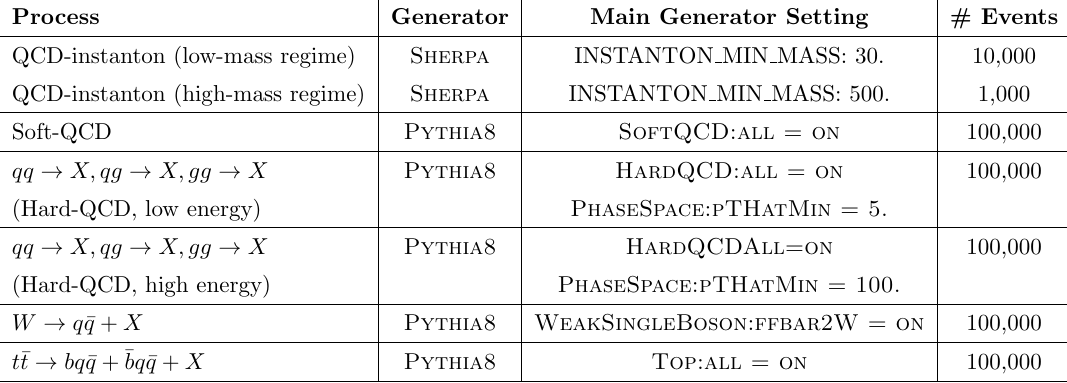
Table 3 . Overview of MC samples used to study observables that allow to discriminate signal and potential background